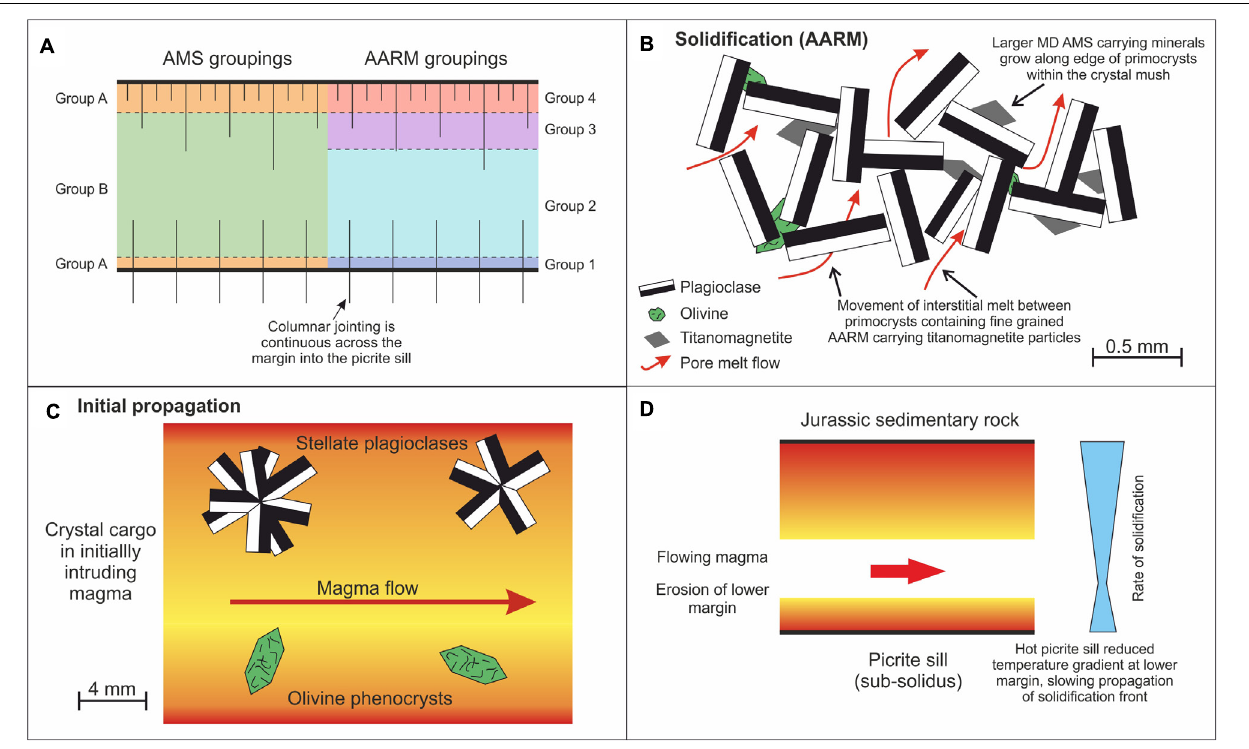
FIGURE 10 | Emplacement model for solidification of the sill inferred from magnetic and petrological fabrics. (A) Solidified crinanite sill showing AMS (Group A and B) and AARM groupings (Group 1 to 4). Dashed lines signify the approximate heights of the groupings. Columnar jointing (vertical solid lines) is continuous across the lower margin into the underlying picrite. (B) Micro-scale diagram showing both the larger MD sized particles growing on the edges of primocrysts that produce the AMS fabrics and pore-melt flow of interstitial fluid around plagioclase and olivine primocrysts to produce AARM fabrics. (C) Stellate plagioclase crystals and euhedral olivine phenocrysts present within the initially intruding magma. (D) Schematic diagram showing magma being emplaced between Jurassic sedimentary country rocks above and picrite sill below. Propagating solidification front from upper and lower margins is asymmetric due to varying host rock